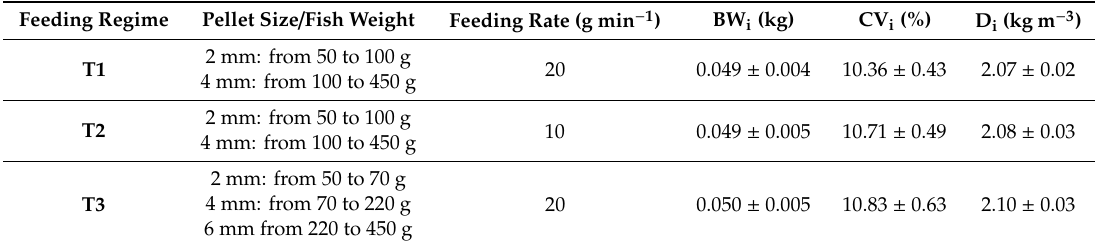
Table 1. Stocking conditions (mean ± standard error) of the experimental feeding treatments BW i : initial body weight; CV i : initial coefficient of variation; D i : initial fish density. Feeding Regime